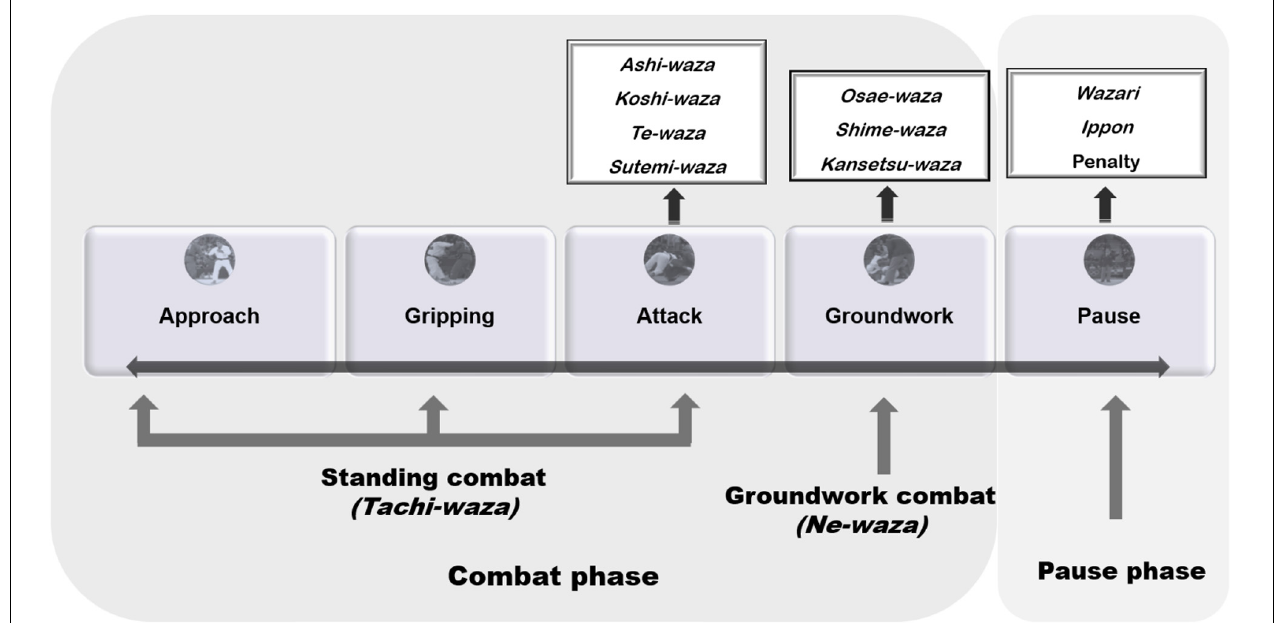
FIGURE 1 | Behavior judo combat model